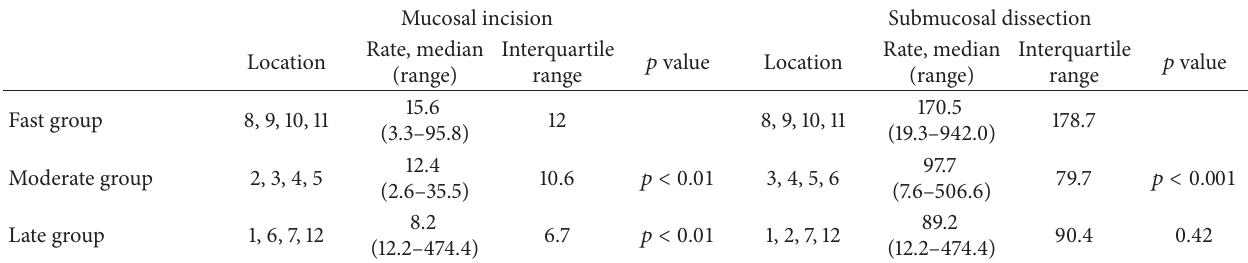
Table 5: Subgroup analyses by procedure time for mucosal incision and submucosal dissection on